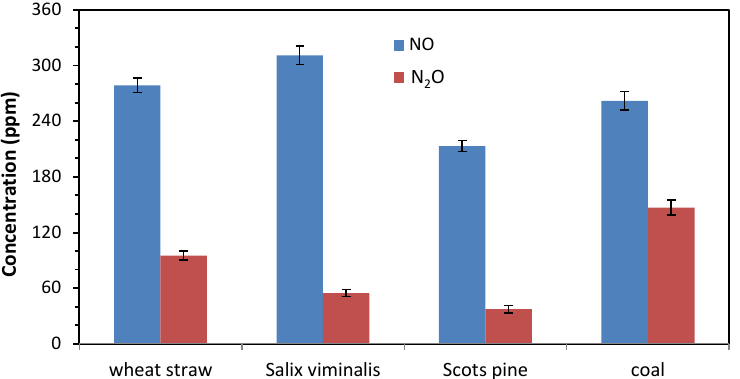
Figure 2. Effect of fuel type on the total NO and N 2 O concentrations during air combustion. Vertical bars represent standard deviation.